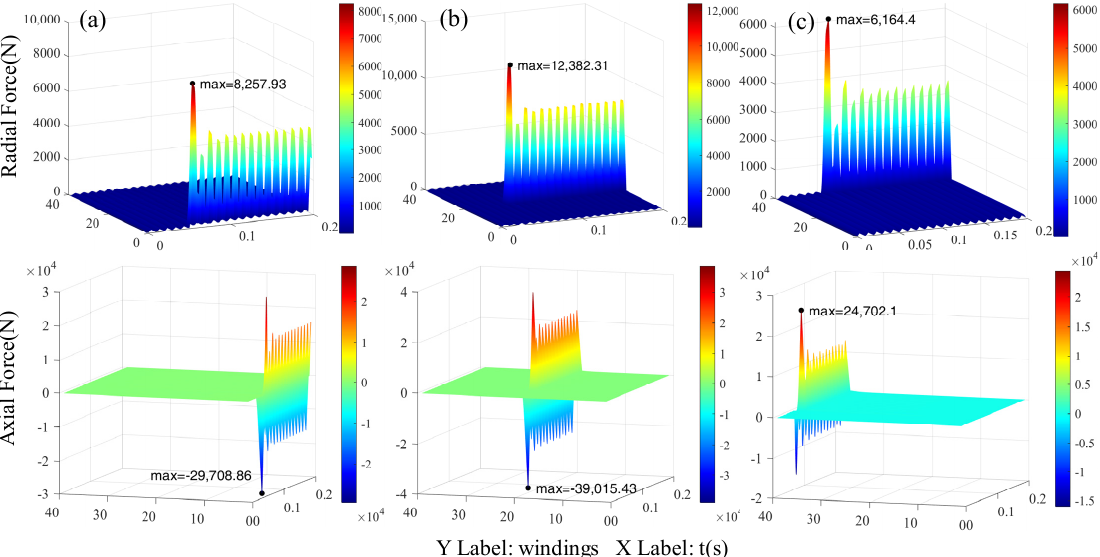
Figure 9. The radial force and axial force of per-turn wire of LV1 outermost winding under three cases of TTFs. ( a ) Top turn-to-turn fault. ( b ) Middle turn-to-turn fault. ( c ) Bottom turn-to-turn fault. Table 4. The change multiples of axial peak resultant forces of windings.